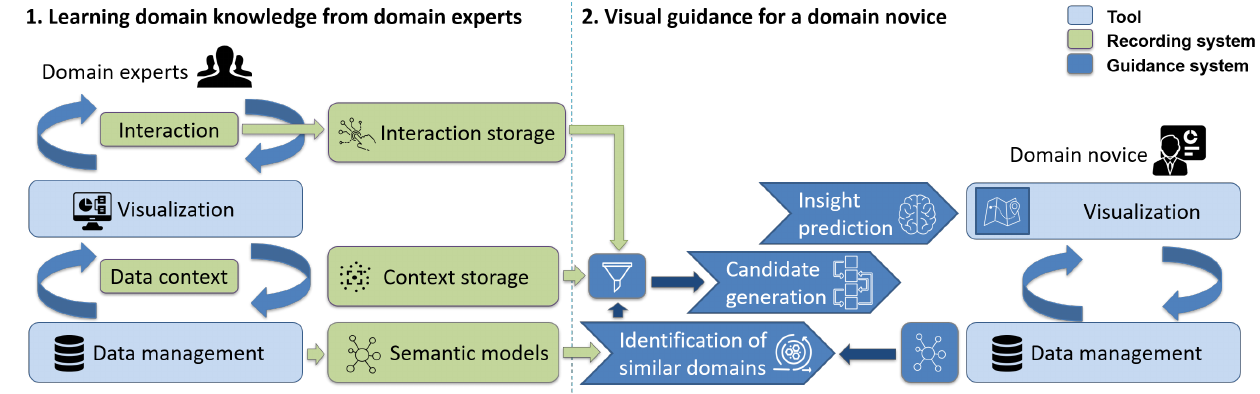
Figure 1. Overview of our system